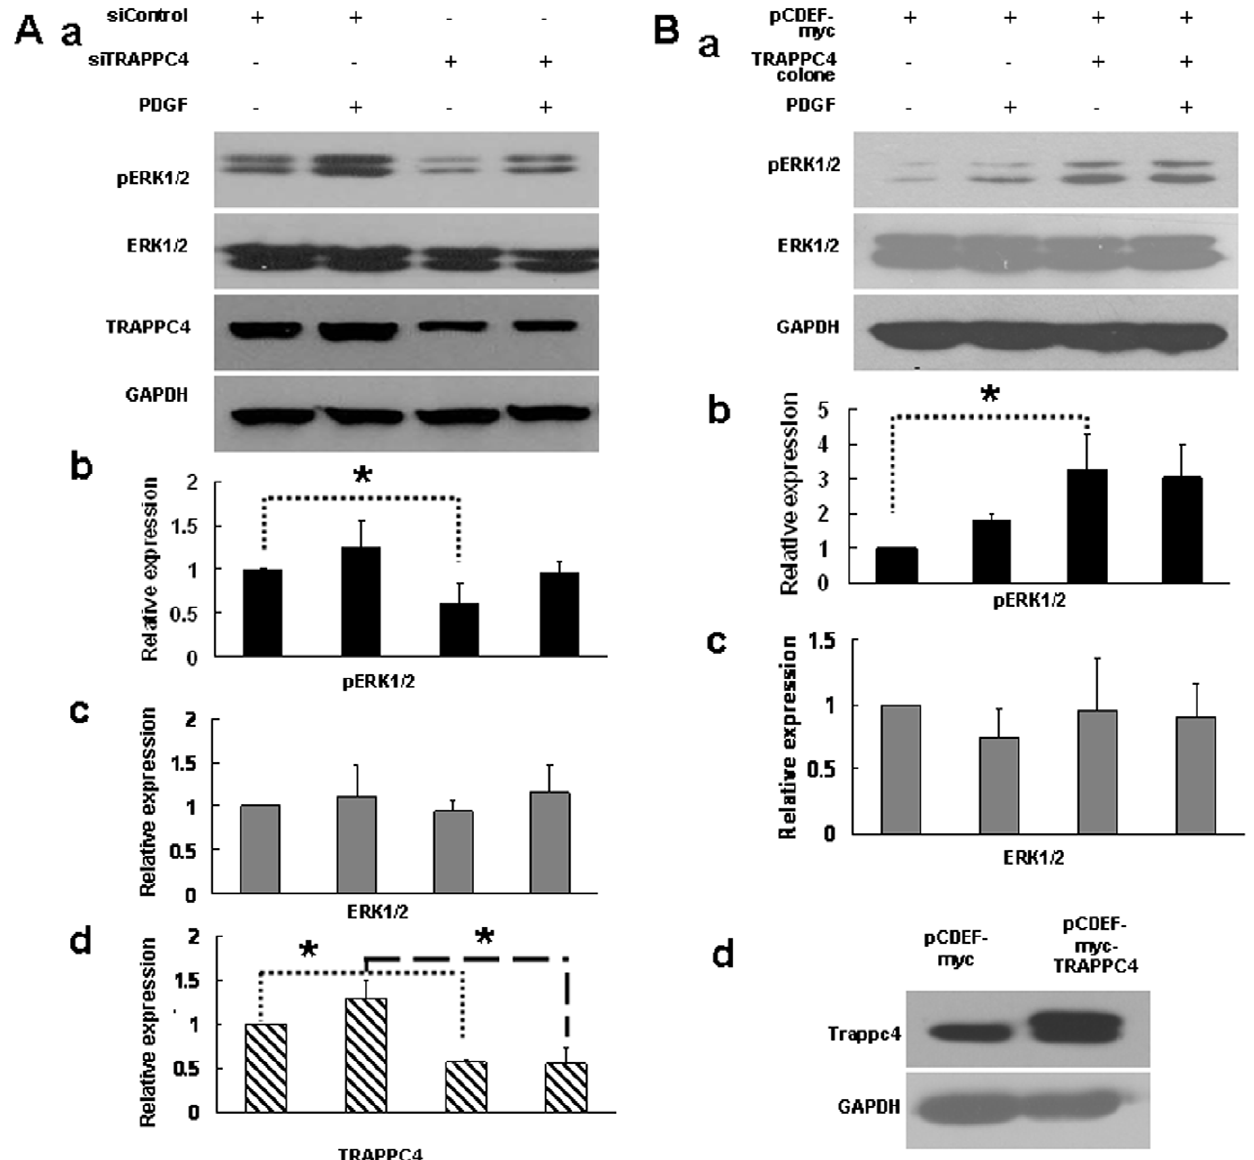
Figure 2. Expression of TRAPPC4 influences the activation status of ERK1/2 in CRC cells. Cells were lysed, and equal amounts of protein were analyzed by Western blot analysis using antibodies against phospho-ERK1/2 (pERK1/2), or ERK1/2, or TRAPPC4. The density of the Western blot bands were normalized to the amount of GAPDH protein. The data shown are representative of three replicate experiments. *, p , 0.05. A. Cells were transfected with TRAPPC4 siRNA (siTRAPPC4) to knockdown TRAPPC4 expression or with Negtive Control siRNA (siControl) as control; Also cells were treated with PDGF to activate ERK-MAPK pathway, or with its solvent (PBS + 0.1 BSA) as control. B. Cells were transfected with pCDEF-myc-TRAPPC4 vector to overexpress TRAPPC4 protein or with pCDEF-myc vector as control; Also cells were treated with PDGF to activate ERK-MAPK pathway, or with its solvent (PBS + 0.1 BSA) as control.